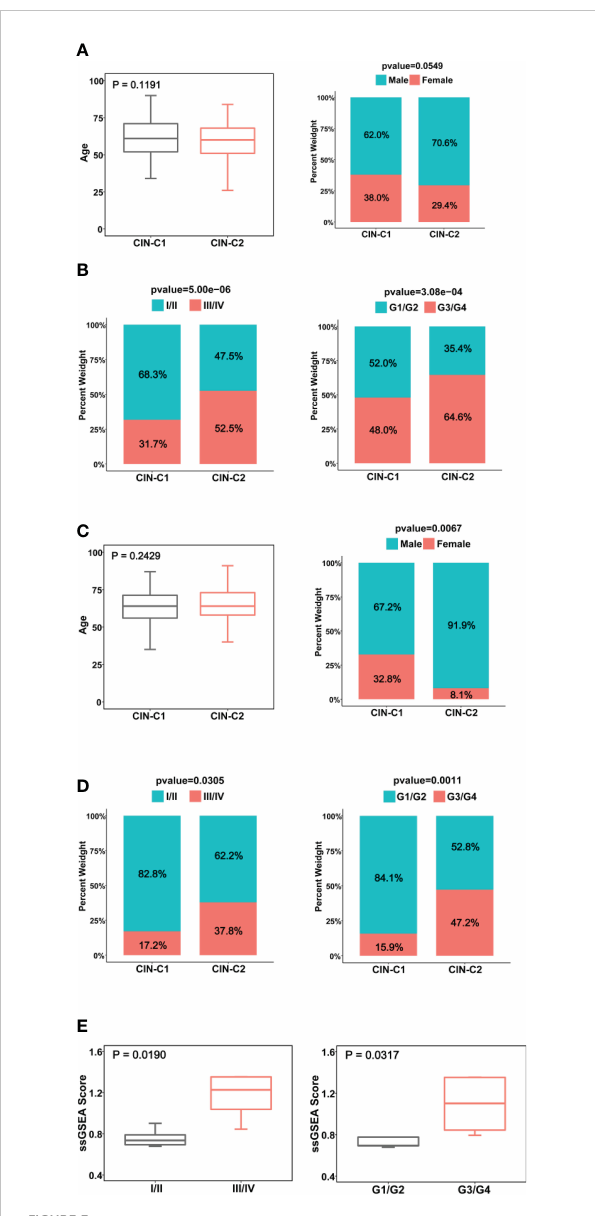
FIGURE 3 Association between CIN25 subtypes and clinic-pathological characteristics in ccRCCs. (A, B) The TCGA cohort. CIN25 subtypes were associated with stages and grades, but not age and gender. (C, D) The E-MTAB1980 cohort. CIN25 subtypes were associated with stages and grades but not age. More female patients were in the CIN25-C1 group. (E) The present cohort of 10 patients. Advanced stages and grades of ccRCC tumors exhibited signi fi cantly higher CIN25 ssGSEA scores. The CIN25 ssGSEA score was calculated as described in the a signi fi cantly positive correlation between telomerase and CIN25 ssGSEA scores ( R = 0.43, P < 2.22E-16) (Figure 4C). CIN is one subtype of genomic instability, whereas the later also includes several other forms of genomic aberrations such as nucleotide instability (NIN), microsatellite instability (MSI), homologous recombination de fi ciency (HRD), etc. (41). Thus, we